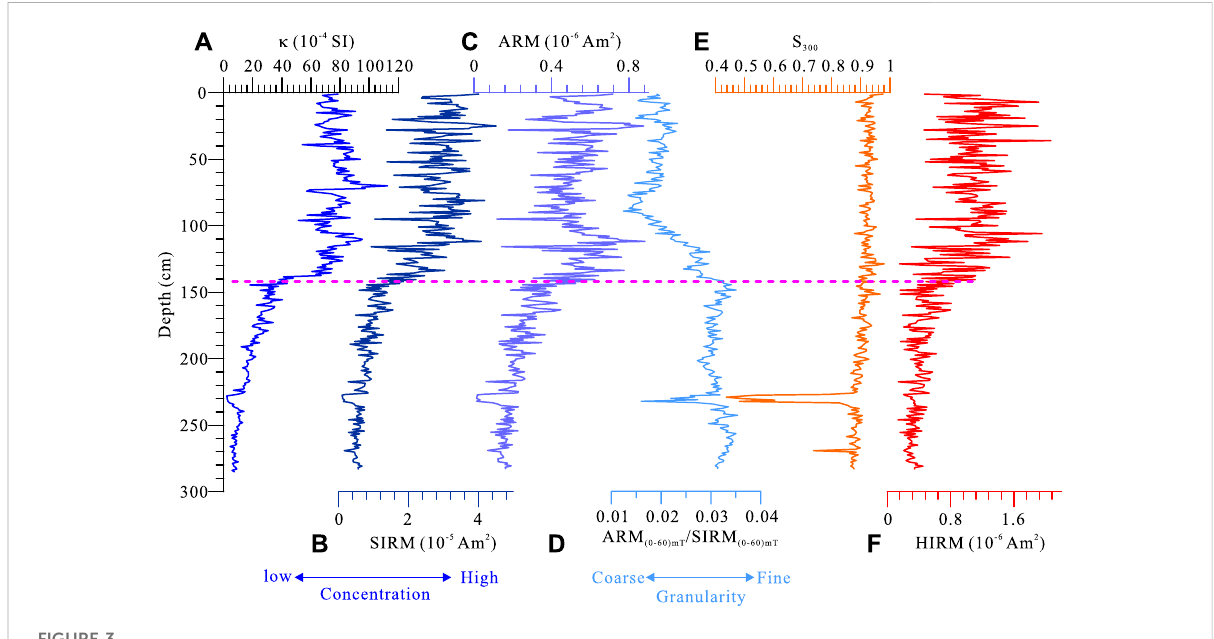
FIGURE 3 Downcorevariationsinenvironmentalmagnetismproxiesofvolumemagneticsusceptibility( κ ) (A) ,saturationisothermalremanence(SIRM) (B) ,